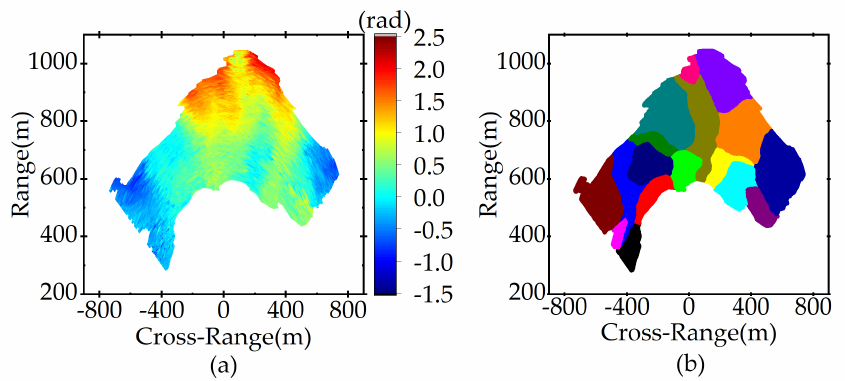
Figure 14. Clustering partition result of the 7th interferogram by the proposed method: ( a ) pre- processed result, ( b ) partition result. Different colors in ( b ) represent different clusters.